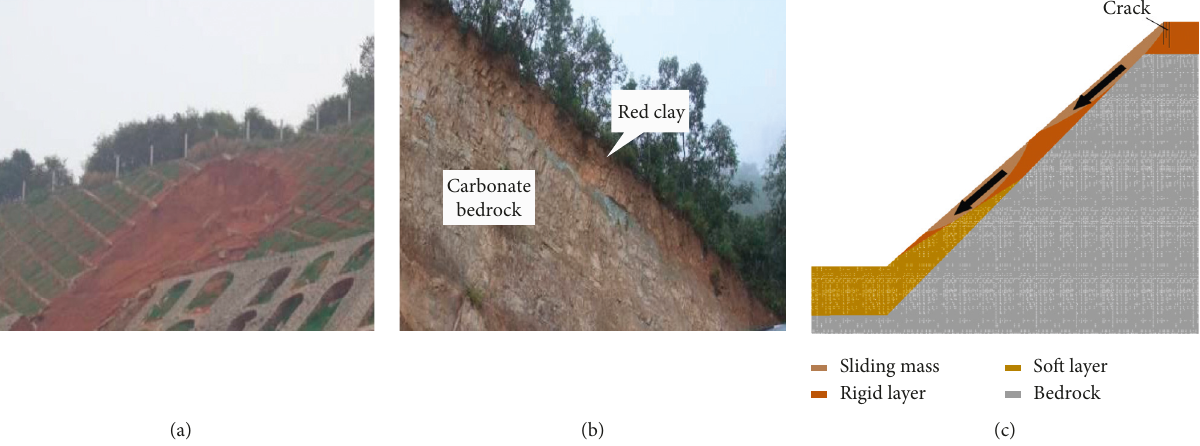
Figure 1: Integral sliding along the stratum interface.